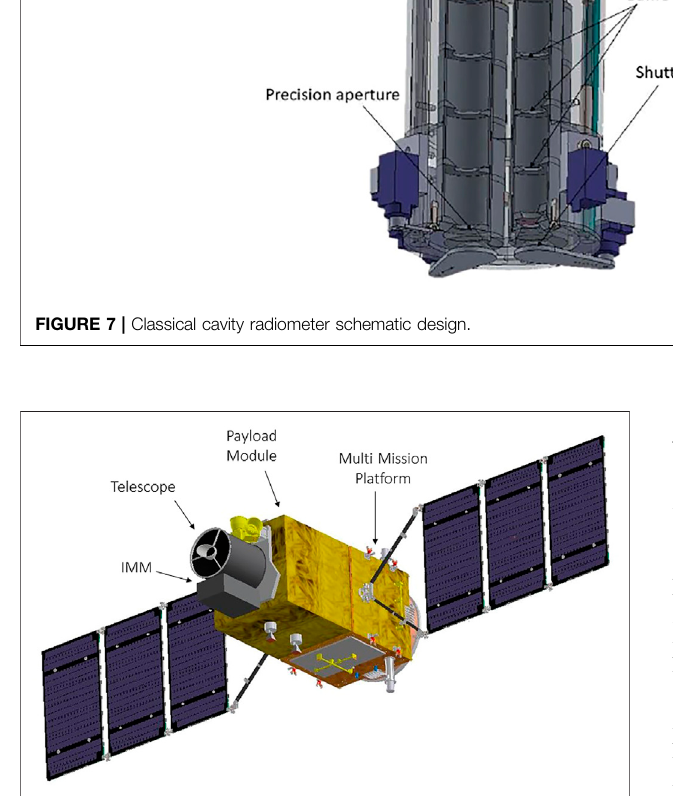
FIGURE 8 | Schematic representation of GSST mission on the multi- mission platform (PMM).